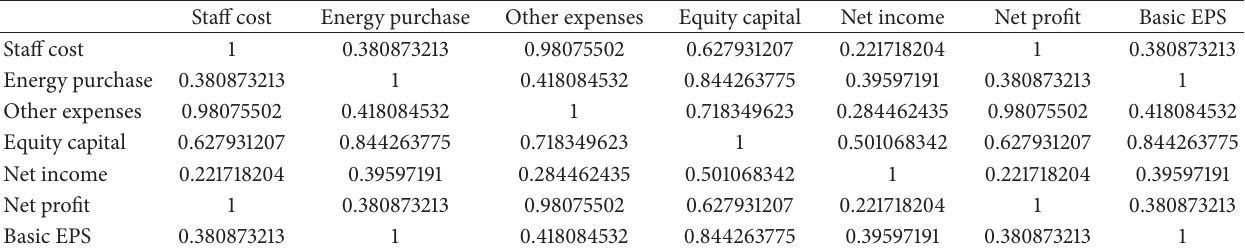
Table 6: Correlation coefficient (2014).